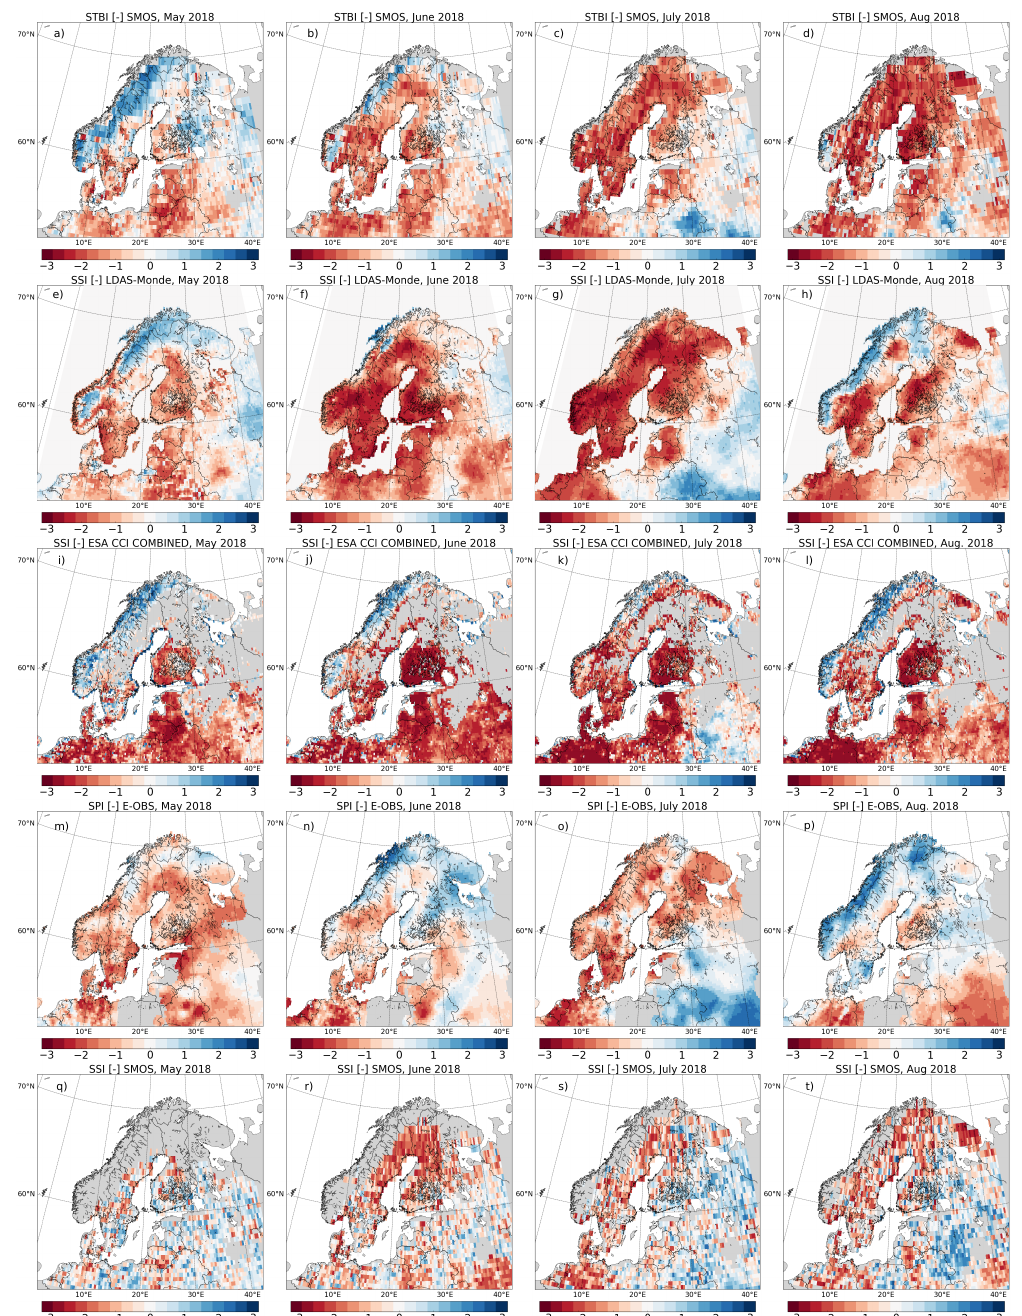
Figure 4. Drought indices, blue/red is above/below average precipitation, Tb H or soil moisture. Grey colour indicates regions without data. Columns from left to right are for May, June, July and August. ( a – d ) Standardized microwave Brightness Temperature Index (STBI_SMOS). ( e – h ) Standardized Soil moisture Index (SSI_LDAS). ( i – l ) Standardized Soil moisture Index ESA CCI (SSI_ESA_CCI). ( m – p ) Standardized Precipitation Index (SPI-1). ( q – t ) Standardized Soil moisture Index SMOS